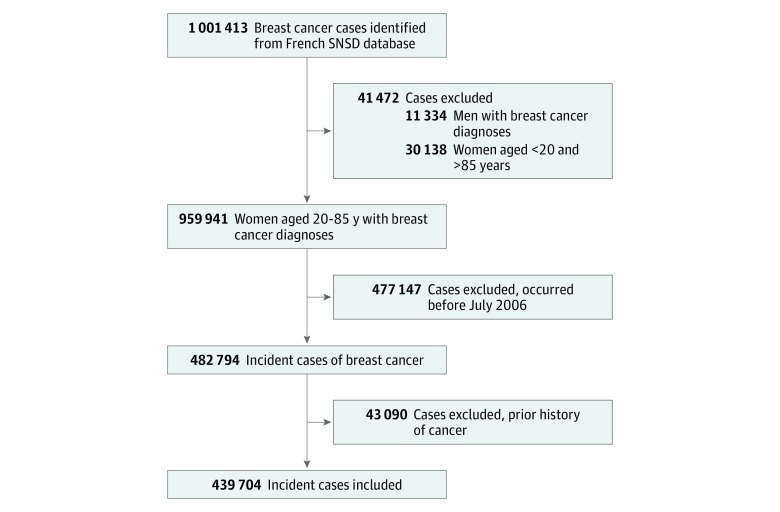
Study Population Flow DiagramSNDS is the French National Health Data System.